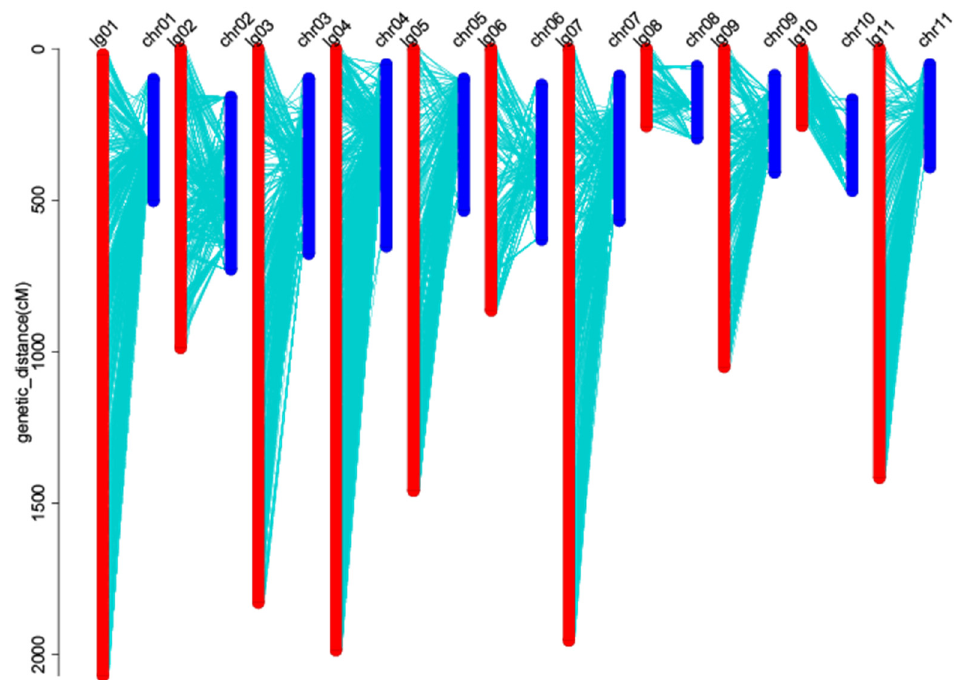
Figure 2. Integration map collinearity analysis based on markers’ positions on the physical map (bp) indicated in blue bars mapped to the positions on the genetic map (cM) indicated in red bars.